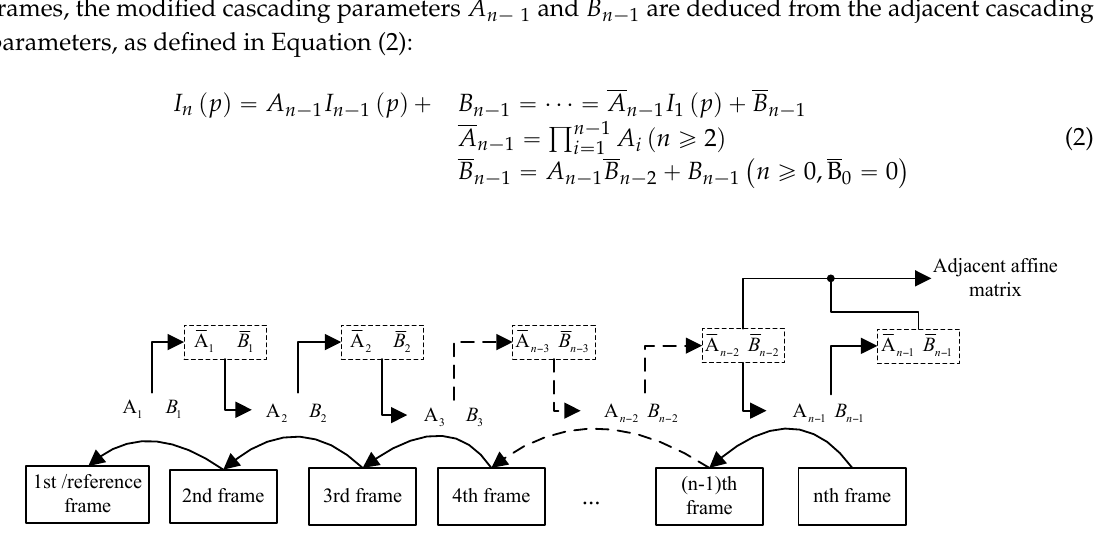
Figure 3. Adjacent affine model defined by using cascading parameters in the video sequences.